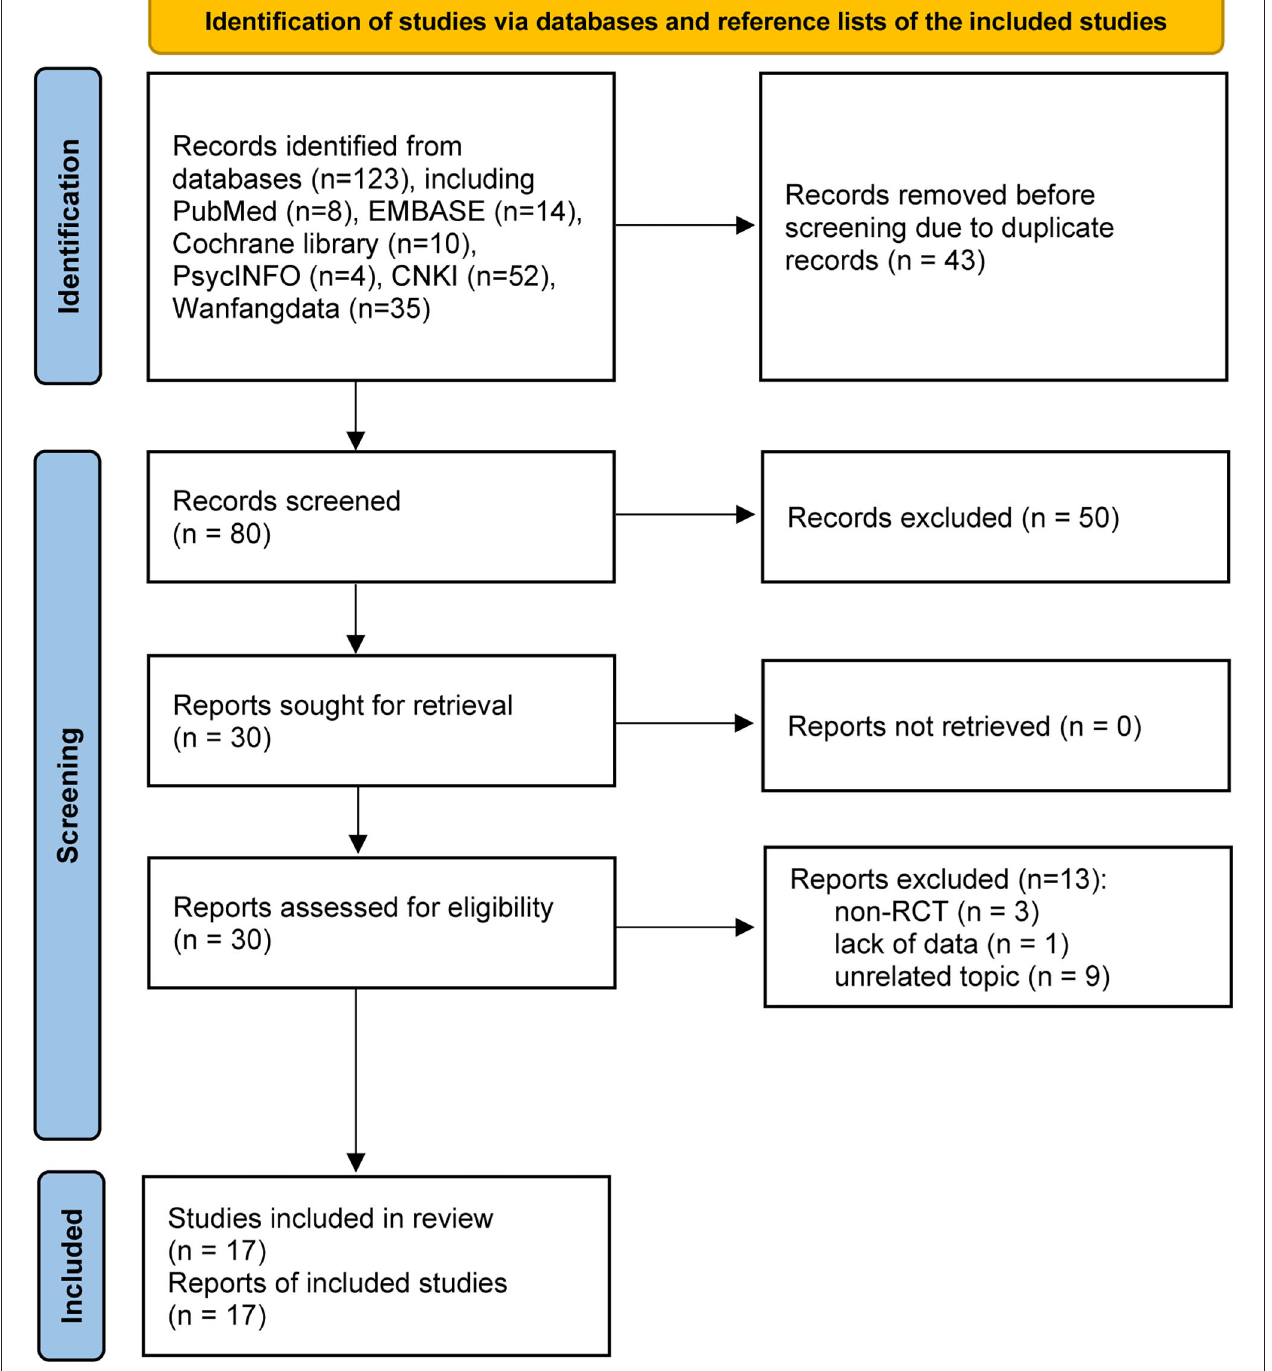
FIGURE 1 | PRISMA flowchart of study retrieval and selection process. CNKI, China National Knowledge